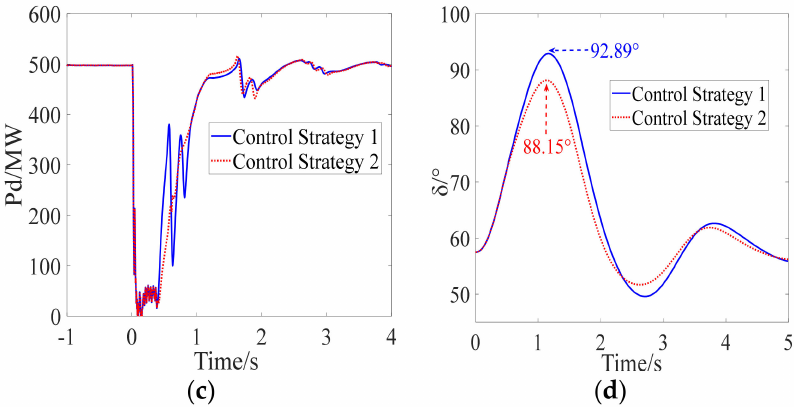
Figure 14. Simulation results of Scenario 2. ( a ) Inverter bus voltage, ( b ) extinction angle, ( c ) DC power, ( d ) relative rotor angle.